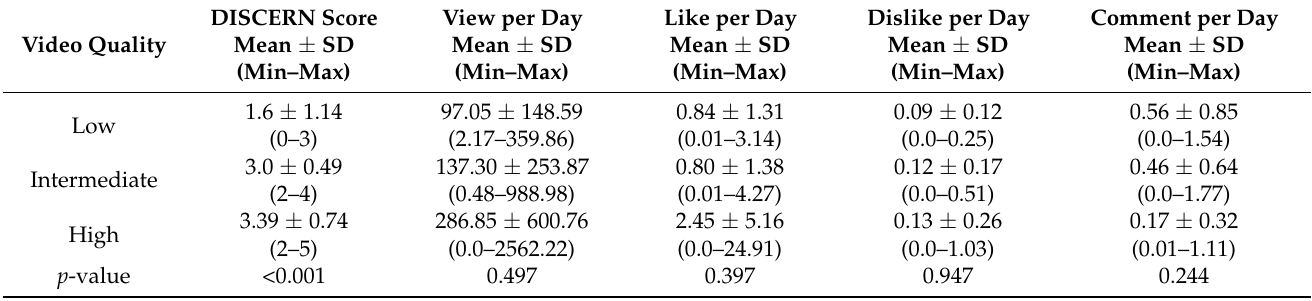
Table 4. Comparison of the video parameters between the low-quality, intermediate-quality and high-quality groups.